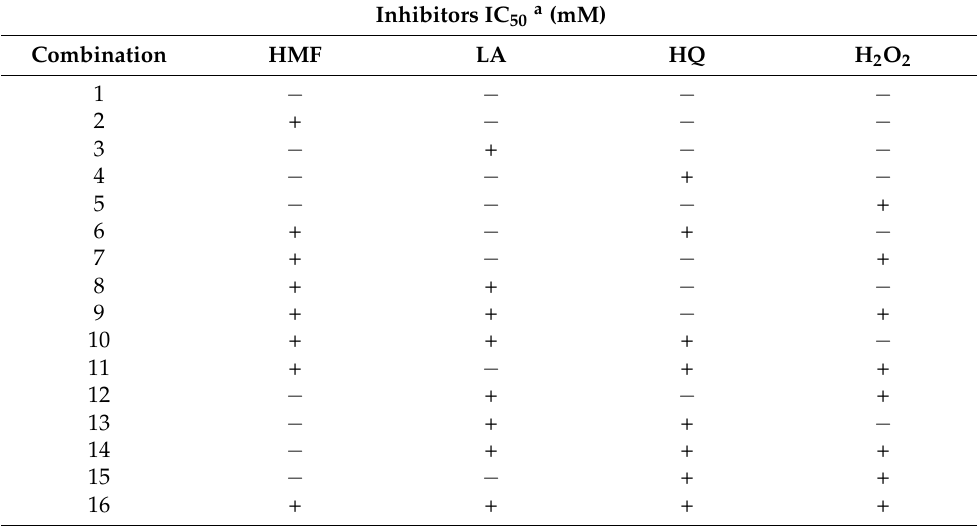
Table 1. Combinations of four different inhibitors at their IC 50